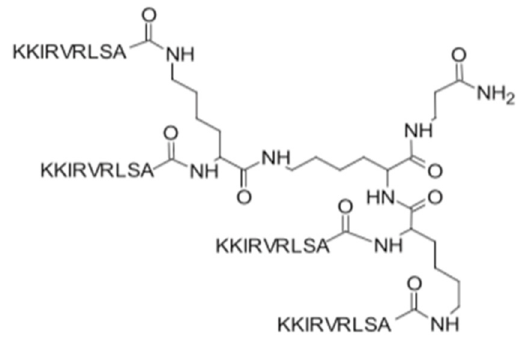
Figure 1. Structure of the SET-M33 peptide